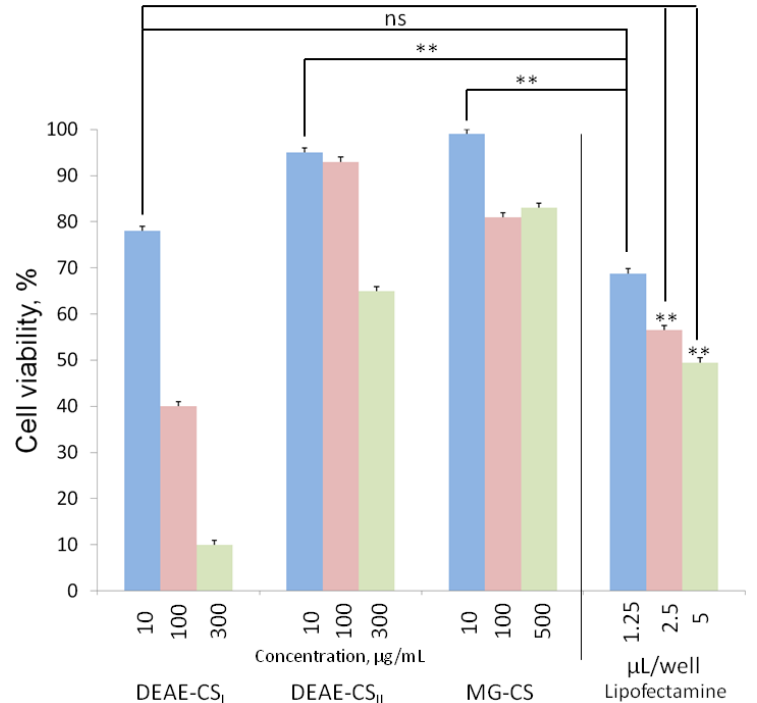
Figure 3. Cell viability after 24 h of incubation with chitosan derivatives. Values are the mean ± standard deviation; measurements were performed as 3 individual experiments with 6 technical